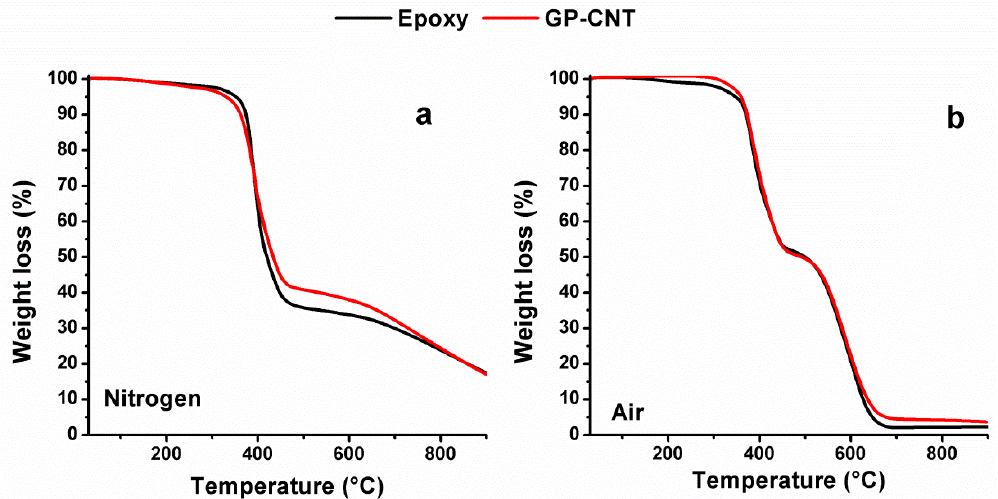
Figure 8. Thermogravimetry profile of epoxy resin with and without carbon nanotubes and GPOSS ( a ): in nitrogen atmosphere ( b ): in air.